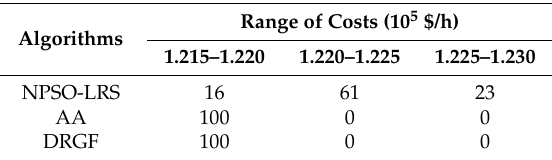
Table 5. Frequency of convergence for 40 units test system from 100 trials.